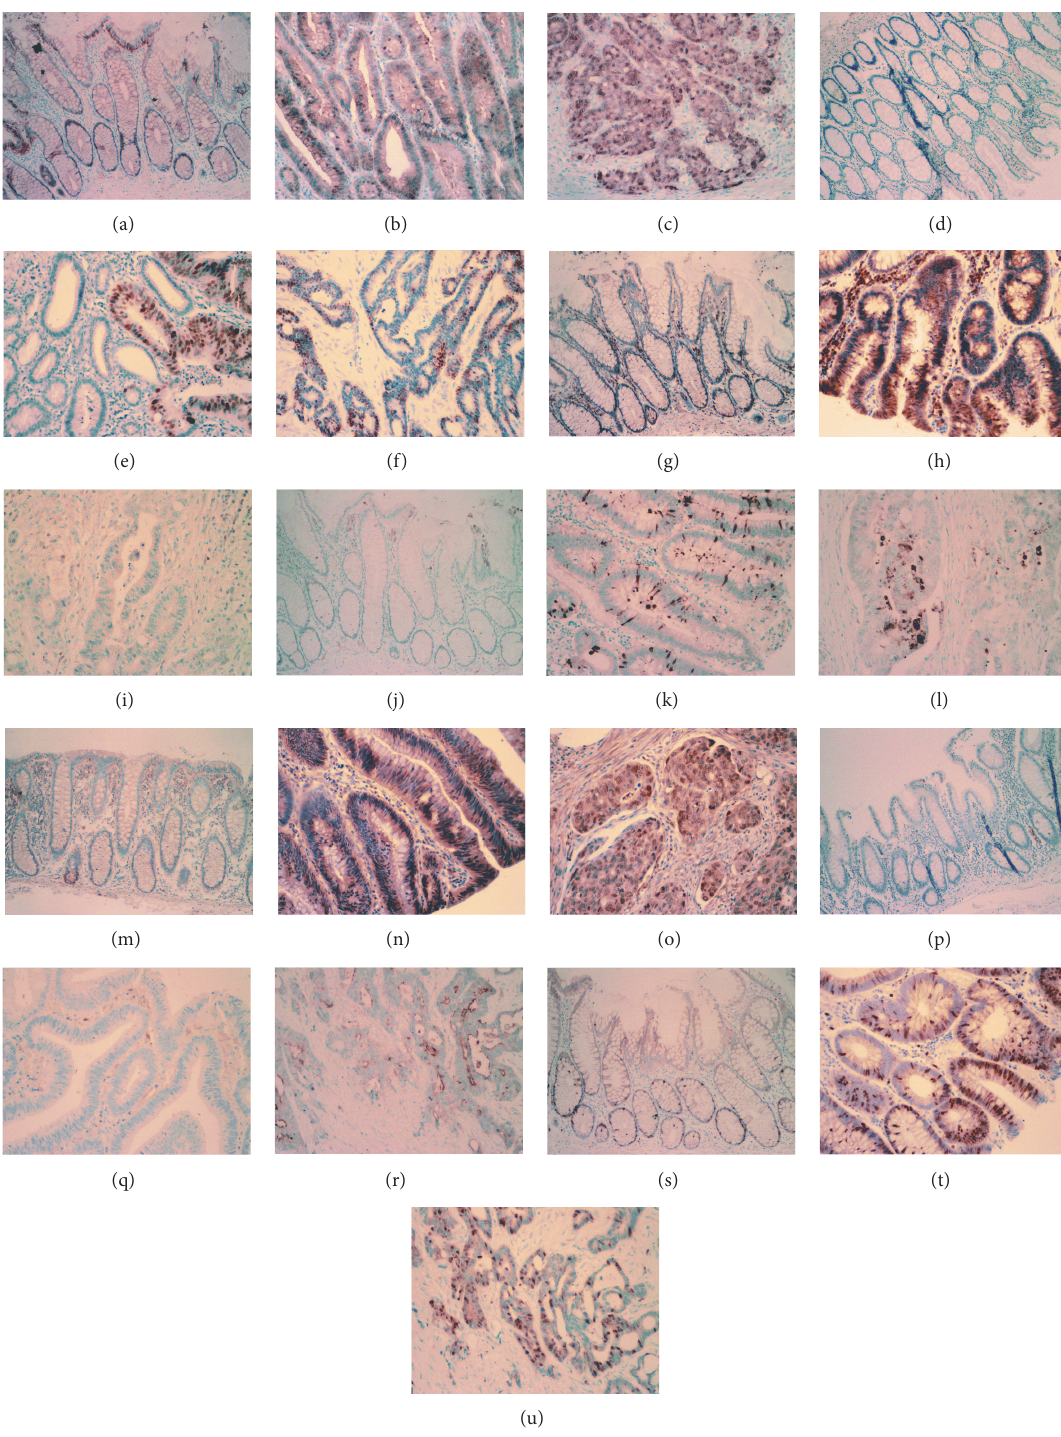
Figure 1: Immunohistochemical stained microphotographs of sections staining for beta-catenin in nonneoplastic mucosa (a), adenoma (b), and adenocarcinoma (c); Ki-67 in nonneoplastic mucosa (d), adenoma (e), and adenocarcinoma (f); p53 in non-neoplastic mucosa (g), adenoma (h), and adenocarcinoma (i); bcl-2 in nonneoplastic mucosa (j), adenoma (k), and adenocarcinoma (l); cyclin-D1 in nonneoplastic mucosa (m), adenoma (n), and adenocarcinoma (o); caspase-3 in nonneoplastic mucosa (p), adenoma (q), and adenocarcinoma (r); CD10 in nonneoplastic mucosa (s), adenoma (t), and adenocarcinoma (u). (a, d, g, j, m, p, and s at 100x magnification; b, c, e, f, h, i, k, l, n, o, q, r, t, and u at 200x